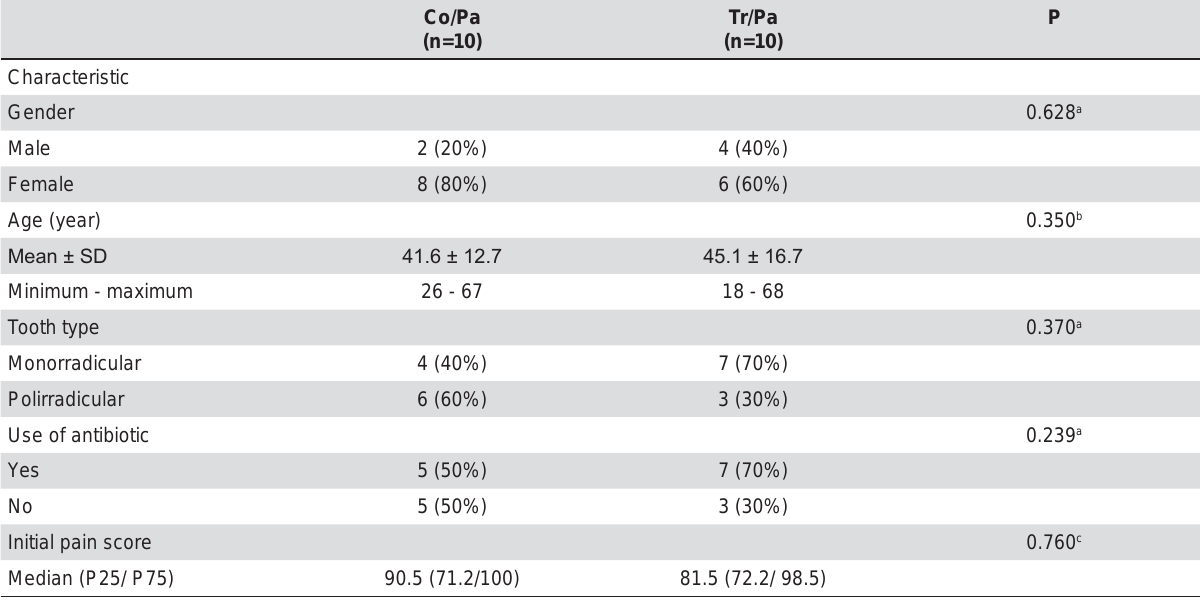
Table 1- Baseline characteristics of the two groups: codeine and acetaminophen combination (Co/Ac) and tramadol and acetaminophen combination